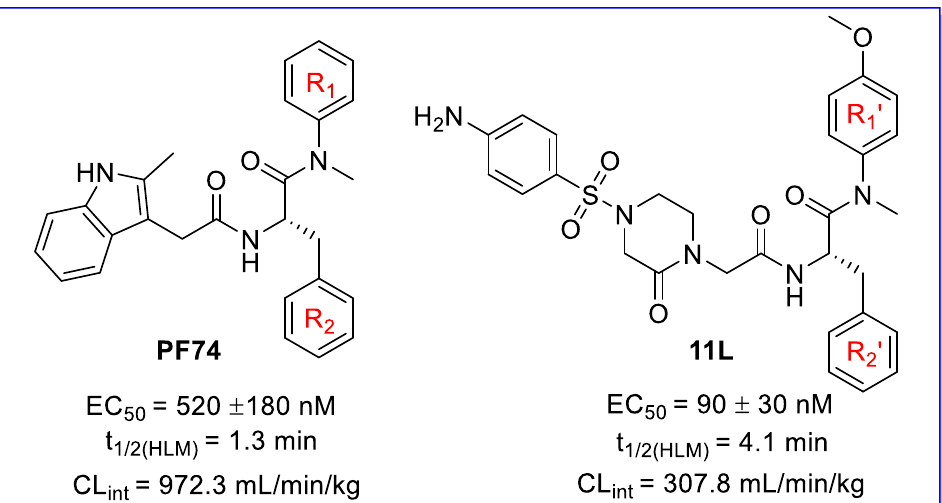
Figure 1. The chemical structures of PF74 and 11L [10]. EC 50 is the concentration of the compound required to achieve 50% protection of TZM-bl cells against HIV-1-induced cytopathic effect, determined in at least triplicate against HIV-1 in TZM-bl cells; t 1/2 is the half-life; and CL int is the intrinsic clearance.